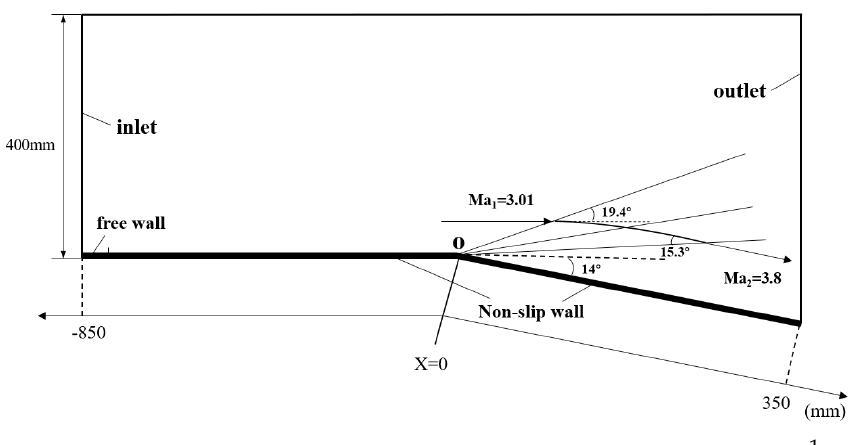
1 = 19.4 ◦ and Ma 1